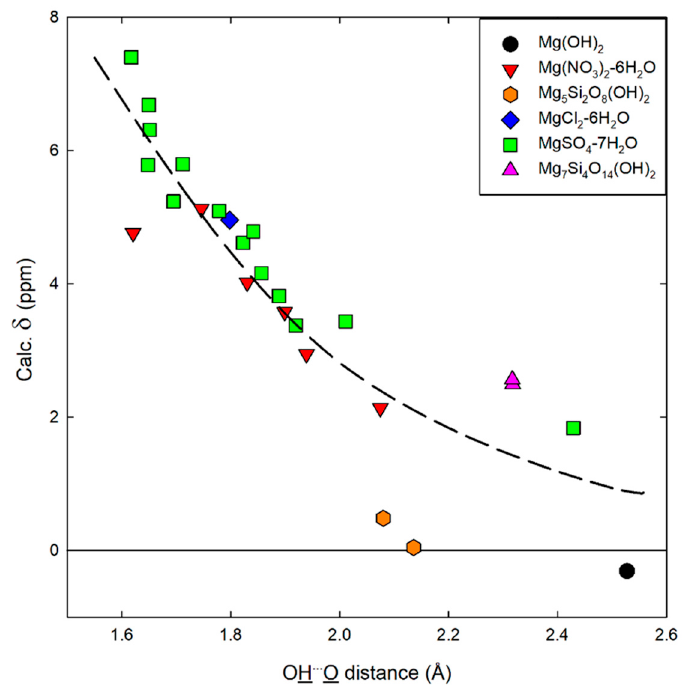
Figure 5. Calculated 1 H-NMR isotropic chemical shift ( δ ) values versus OH ... O hydrogen bond lengths (Å) for refence compounds. The dashed line serves as a guide line to the reader.